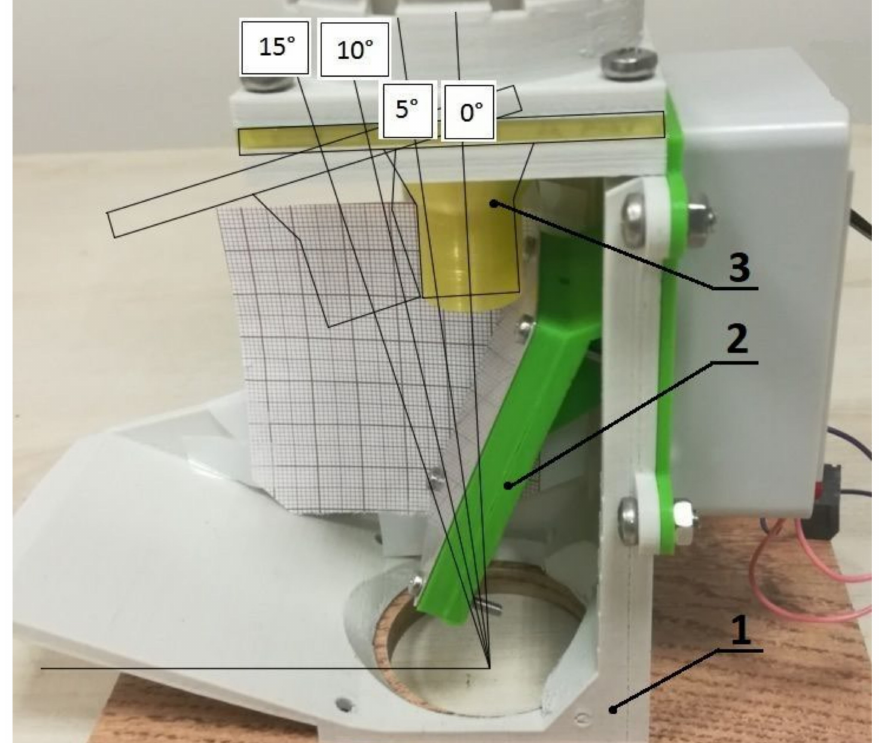
Figure 5. Scheme of the transport tube tilt (seed delivery tube) and its end at angles: 0 ◦ , 5 ◦ , 10 ◦ , 15 ◦ : 1—sensor housing, 2—piezoelectric sensor, 3—exit hole.